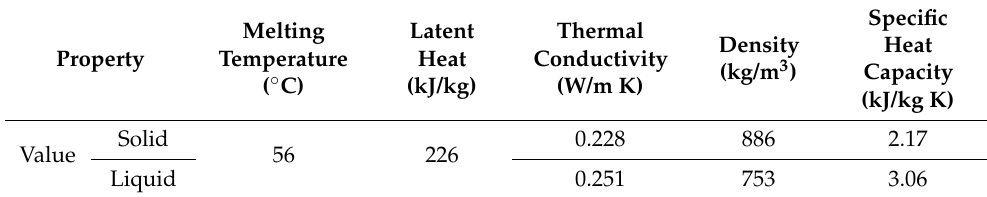
Table 1. PCM properties